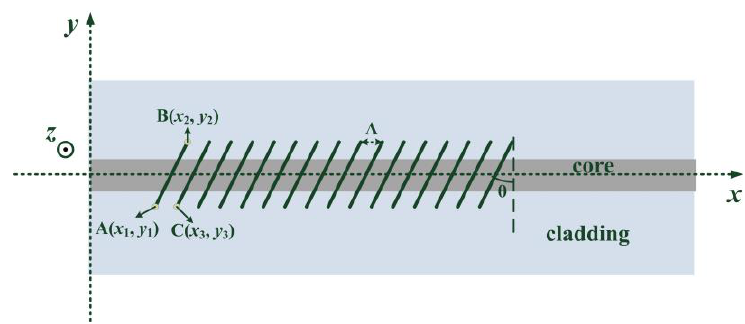
Figure 1. Phase matching condition of the first order harmonic